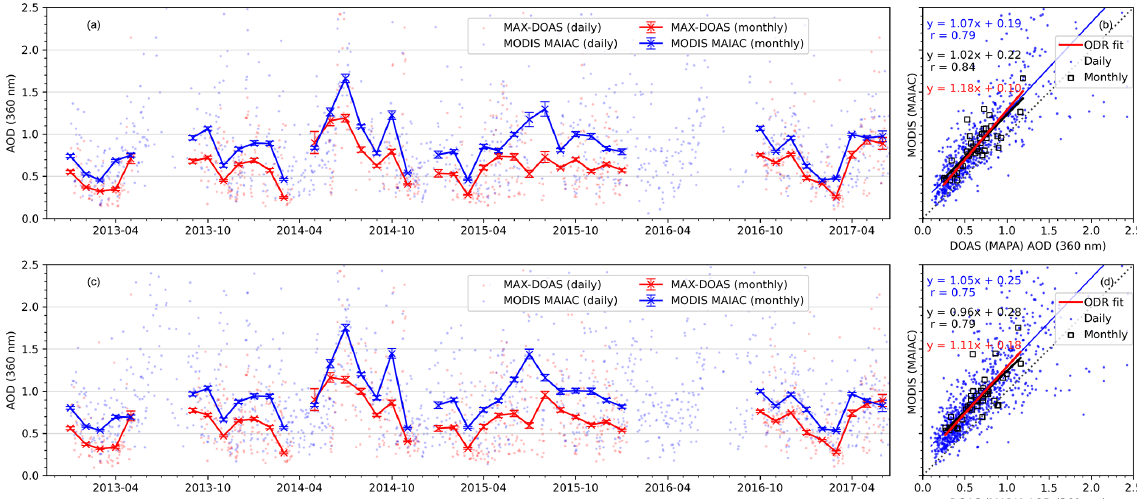
Figure F14. Intercomparison of daily (dots) and monthly mean (lines and markers) AOD at 360nm retrieved from ground-based MAX- DOAS O 4 measurements and from the MODIS MAIAC data product when spatially averaged over 5km (a, b) and 25km (c, d) around Mohali. O 4 dSCD were scaled by a factor of 0.8, as discussed in the main text.